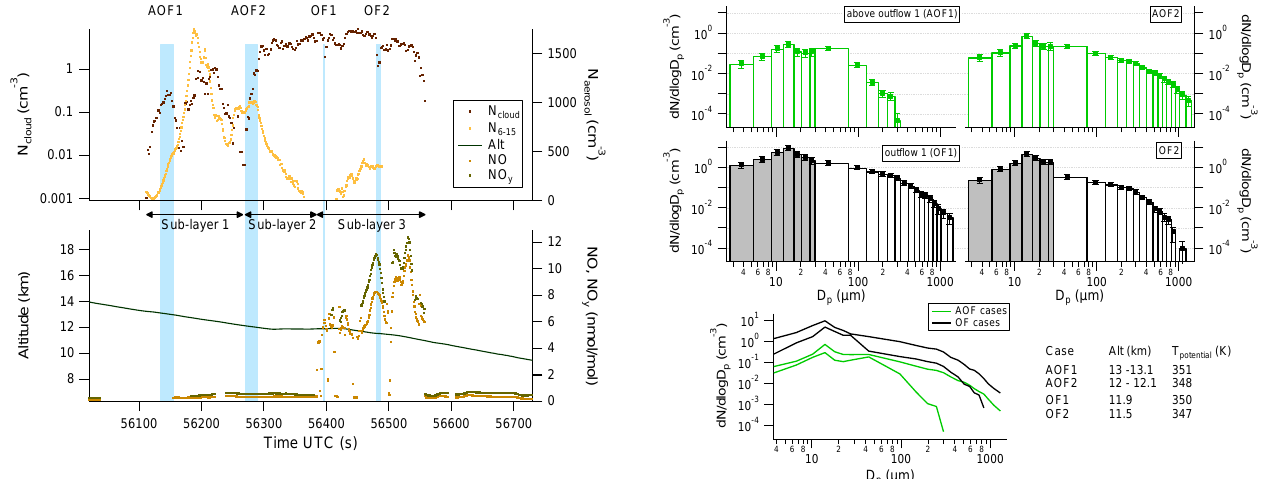
Fig. 5. Cloud particle size distributions measured within the MCS anvil and outflow during descent on 7 August 2006 at the times and for the cases indicated in Fig. 4. The lowest panel summarises the ice particle size distributions of the four upper panels. The shading in the FSSP-100 size range indicates that these measurements are potentially affected by